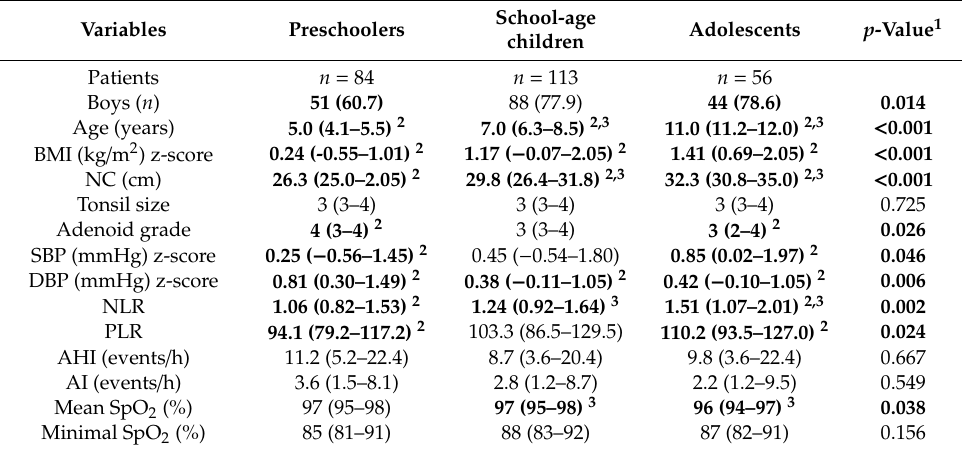
Table 1. Demographic and clinical characteristics of the three subgroups stratified by